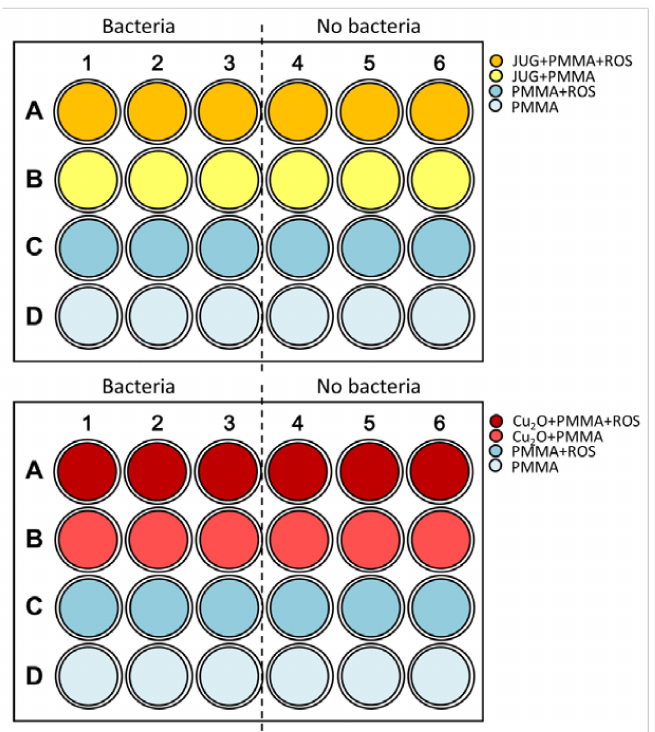
Figure 8. Coupon experimental set-up with coatings (right labels) containing: JUG ( top ) and Cu 2 O ( bottom ). Half of the plates indicate “Bacteria” = wells where bacteria will be inoculated and “No bacteria” wells where no bacteria were added, serving as blanks. JUG = juglone, ROS = rosin, PMMA = poly(methyl